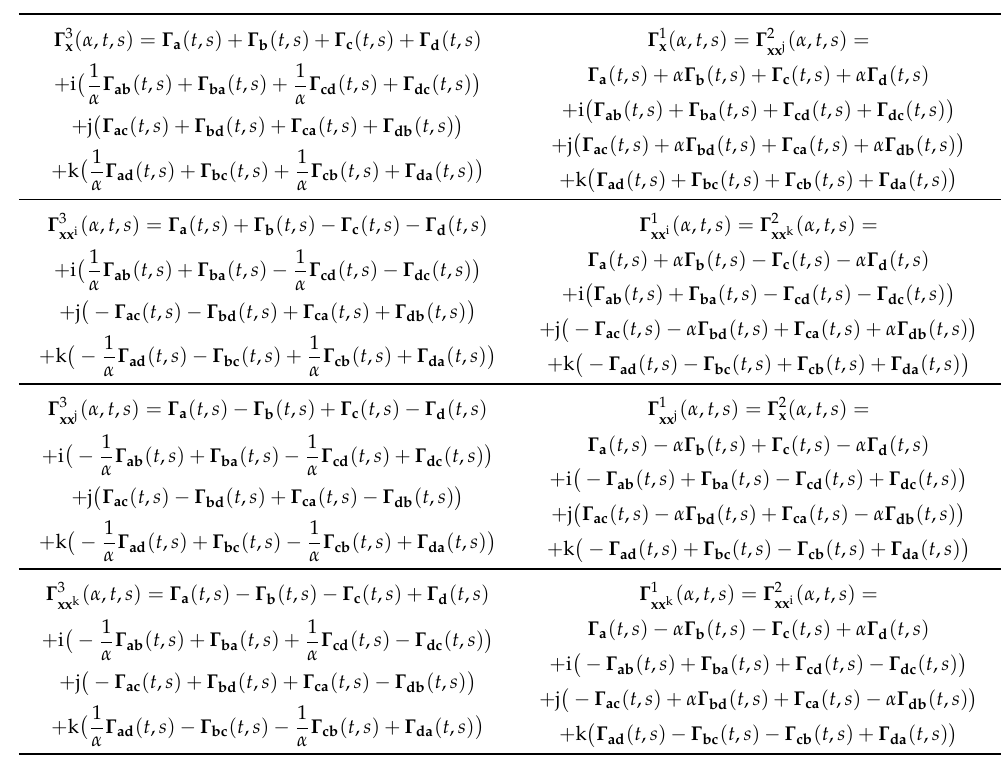
Table A1. Expressions for Γ ν x ( α , t , s ) and Γ ν of the components of x r ( t )